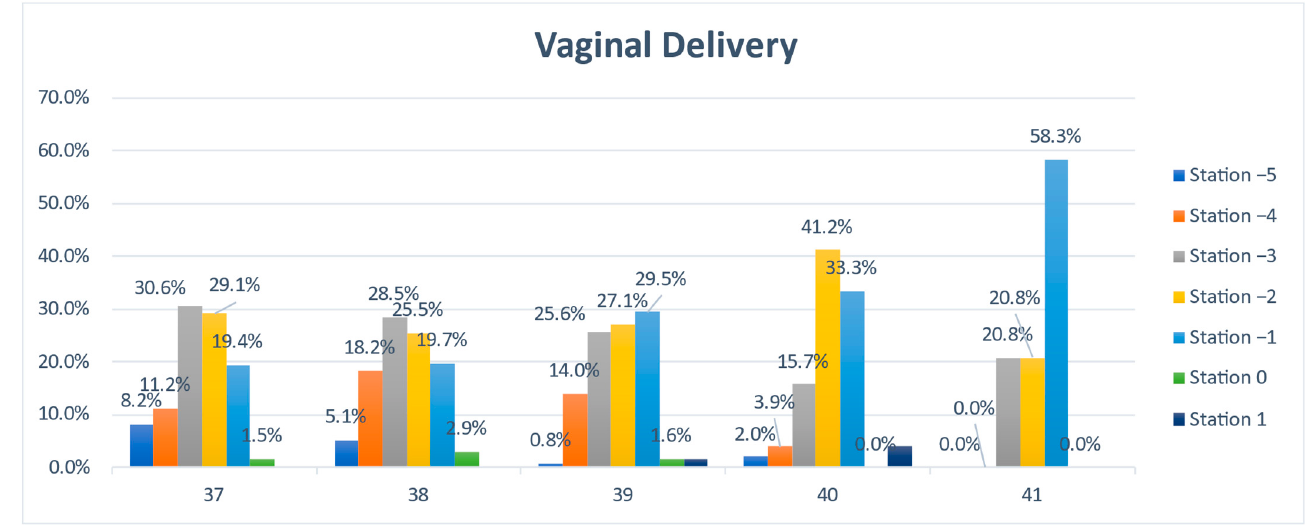
Figure 3. The comparative distribution of the clinical fetal head station at 37 to 41 weeks of gestation in the vaginal delivery group.